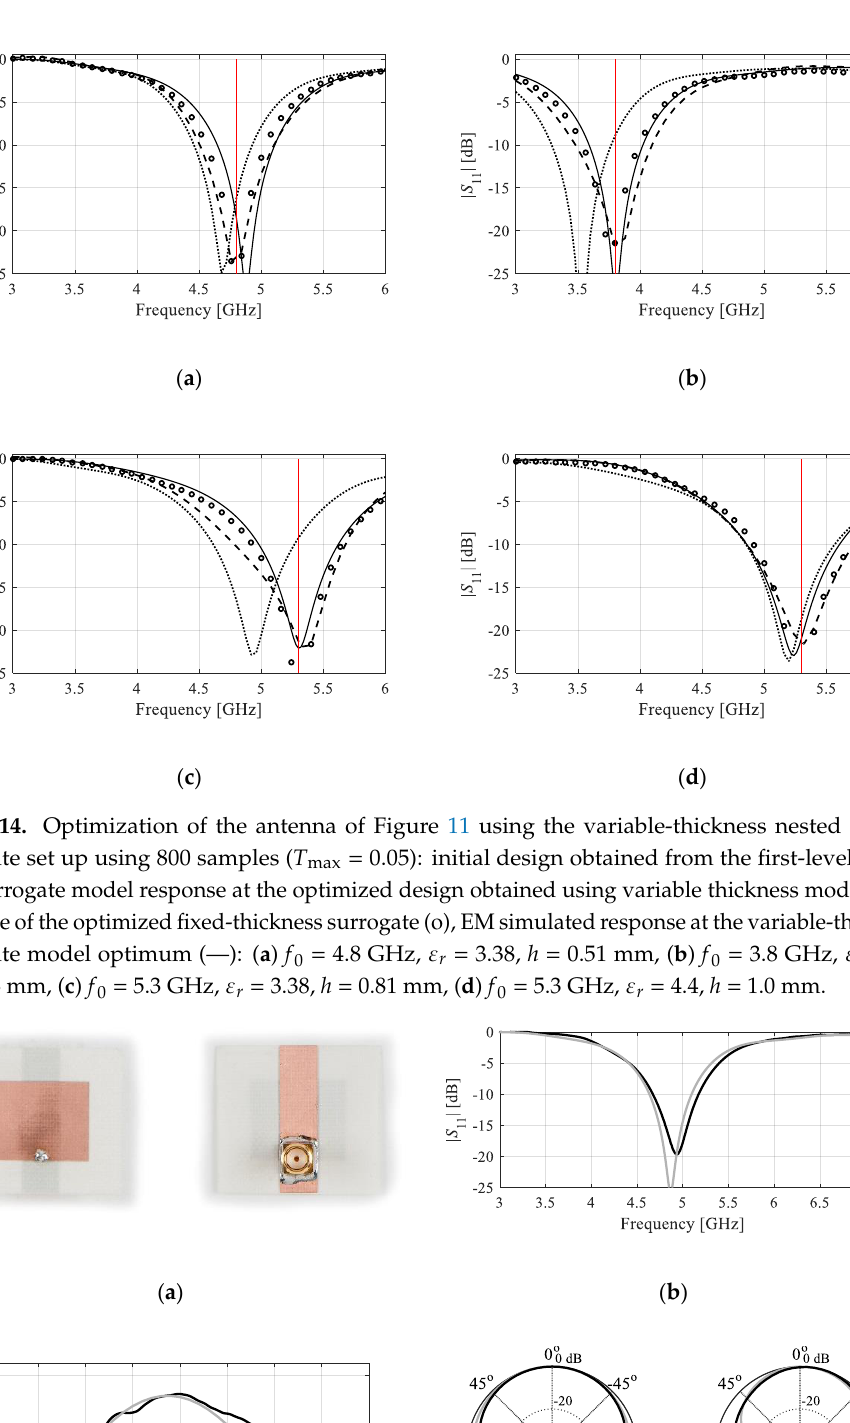
15 of 20 Table 2. Modeling Results for Antenna of Figure 11. Number of training samples